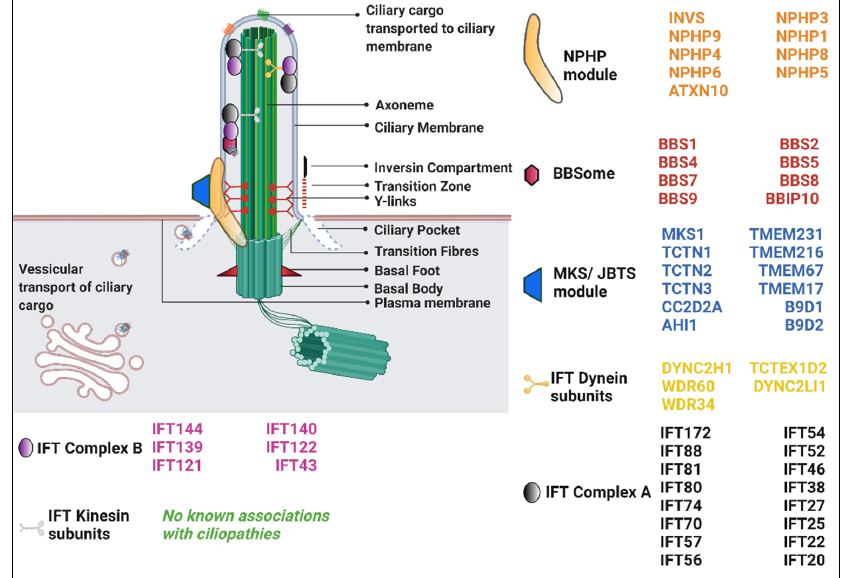
Figure 2. Ultrastructure of cilia and ciliopathy modules: The primary cilium is a highly compartmentalized microscopic organelle with several distinct parts (not drawn to scale). Although each compartment houses proteins belonging to different families, an aberration in their expression cause ciliopathies that can be grouped to specific modules. NPHP module includes, inversin (INVS/NPHP2). Nephrocystin 1, 3, 4, 5, 6, 8, 9 (NPHP1-9), Ataxin 10 (ATXN10); Mutations in proteins causing Bardet–Biedl syndrome (BBS) are located in the BBSome module comprising of proteins (BBS1-9, BBSome-interacting protein of 10Kda (BBIP10/ BBIP1). The Meckel–Gruber syndrome (MKS)/Joubert syndrome (JBTS) module is made of MKS1, Transmembrane Protein 231 (TMEM231), Transmembrane Protein 216 (TMEM216), Transmembrane Protein 67 (TMEM67), Transmembrane Protein 17 (TMEM17), Tectonic Family Member 1-3 (TCTN1-3), B9 Domain Containing 1-2 (B9D1-2), Coiled-Coil And C2 Domain Containing 2A (CC2D2A), Abelson Helper Integration Site 1 (AHI1), Intraflagellar (IFT) family of proteins and associated motor proteins (dynein Dynein Cytoplasmic 2 Heavy Chain 1 (DYNC2H1), Dynein Cytoplasmic 2 Light Intermediate Chain 1 (DYNC2LI1, WDR60, WDR34), Dynein Light Chain Tctex-Type 2B (TCTEX1D2), and kinesin) are critical